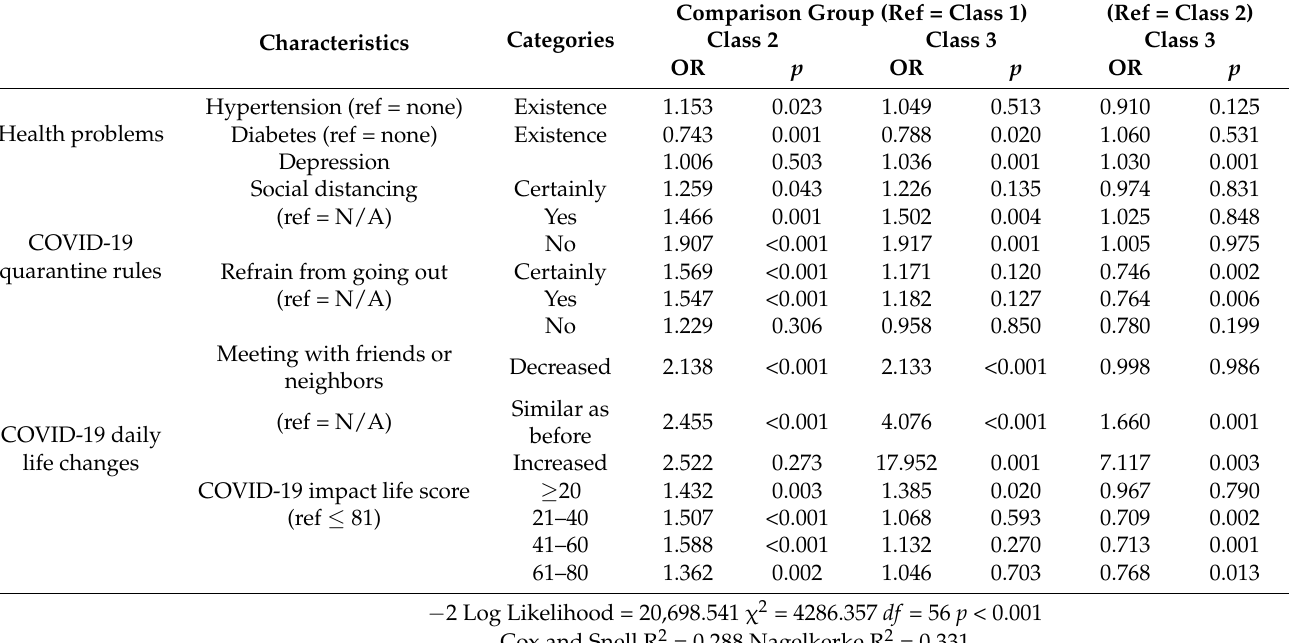
Table 5. Factors affecting latent class